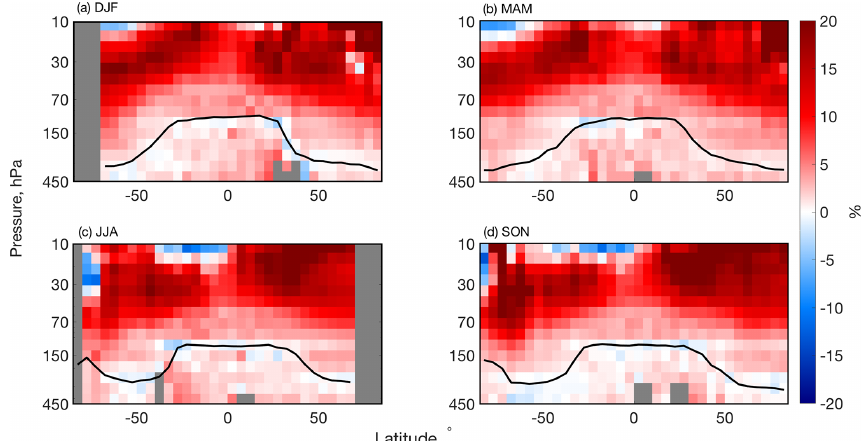
Figure 8. The relative mean of individual ACE-FTS profiles subtracted from CMAM30HR profiles of N 2 O, divided by the ACE-FTS measurements for each season: (a) December–January–February (DJF), (b) March–April–May (MAM), (c) June–July–August (JJA), and (d) September–October–November (SON). The grey regions indicate where no data are